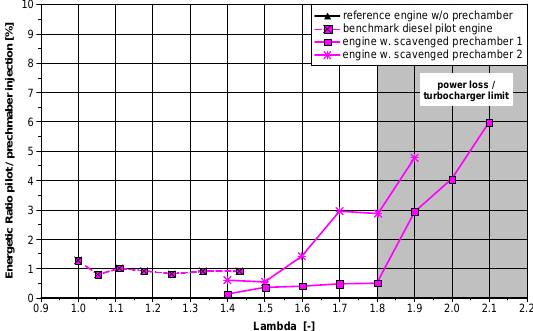
Fig. 13. Energy fraction for Diesel pilot or prechamber fueling for opera- ting point 2 (2000 rpm/220 Nm/bmep 14.0 Fig. 11. Center of combustion settings for operating point 2 (2000 rpm/ 220 Nm/bmep 14.0 bar)